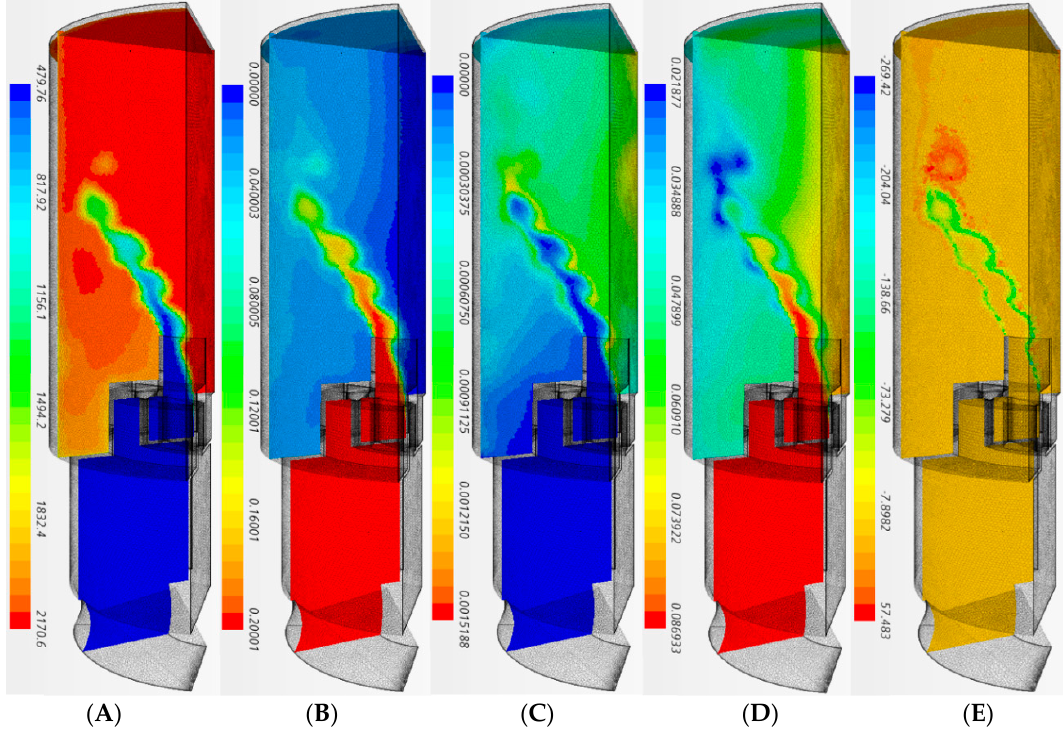
Figure 7. ( A ) Temperature (K); ( B ) ammonia concentration (mol%); ( C ) NO concentration (mol%); ( D ) hydrogen concentration (mol%); ( E ) hydrogen rate of production (kg/m 3 ·s). Operating conditions: 900 kPa, 500 K inlet temperature, 1450 K quartz tube.